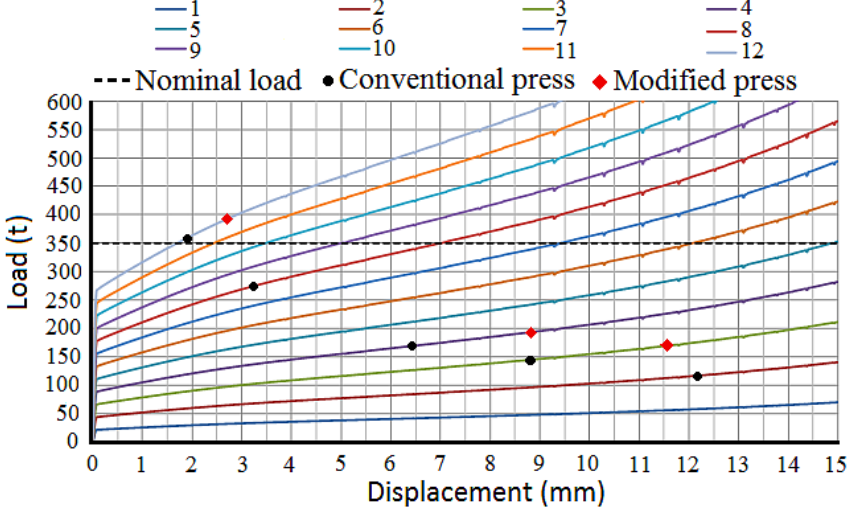
Figure 5. Compression load distribution regarding to the degree of deformation for different number of